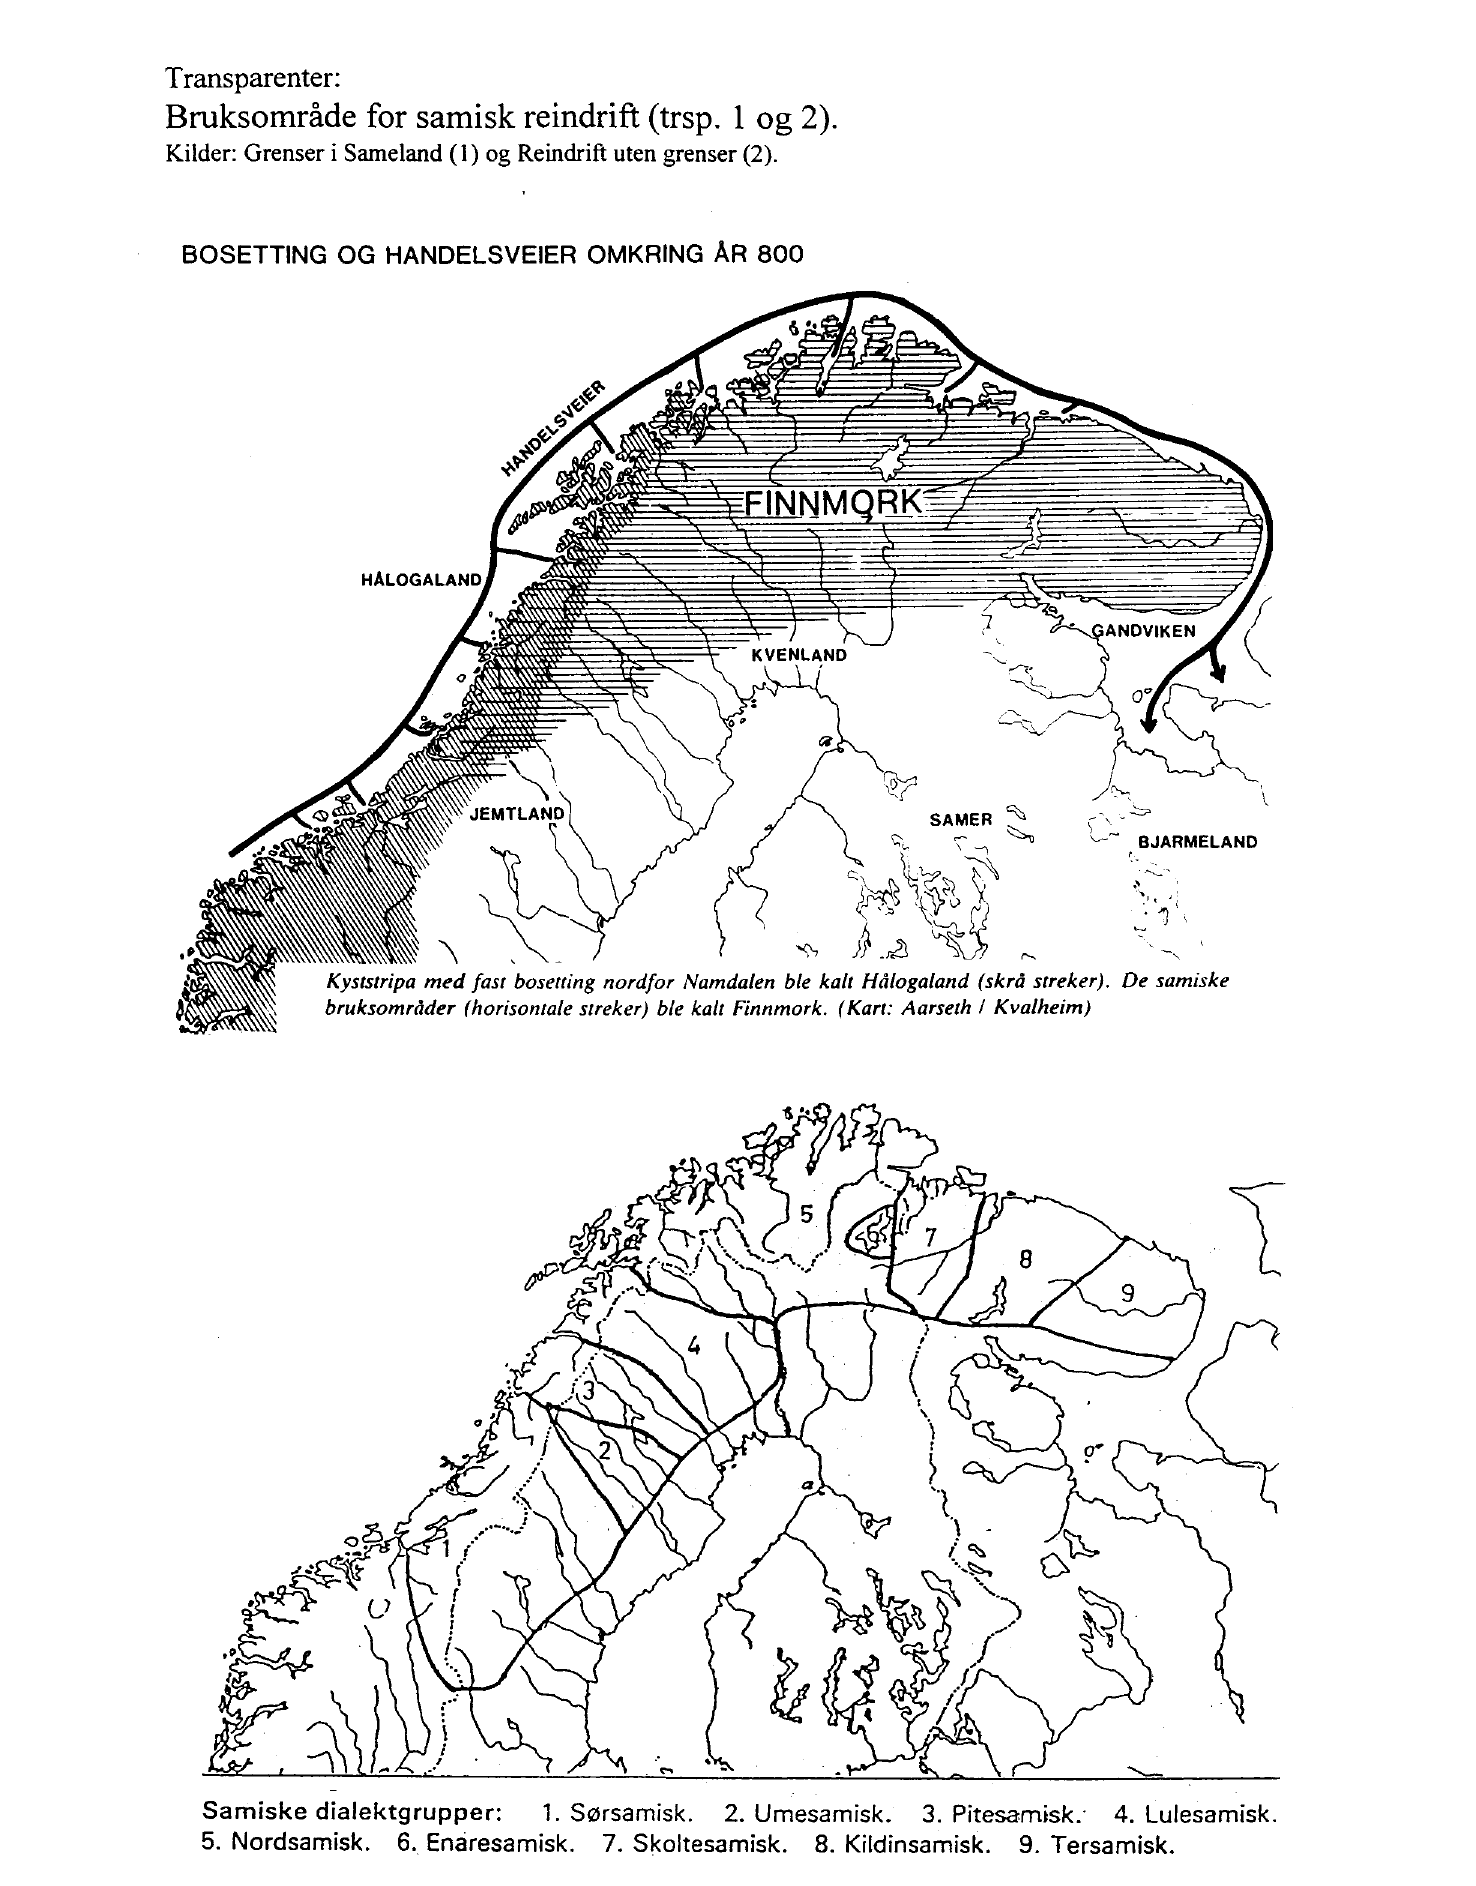
Transparenter: Bruksområde for samisk reindrift (trsp. 1 og